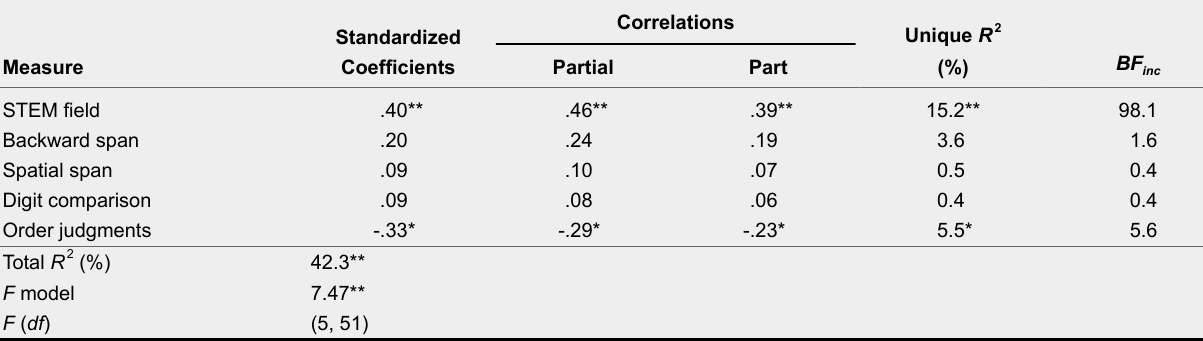
Regression Model for the Symbol Decision Task-Math Including the Inclusion Bayes Factor